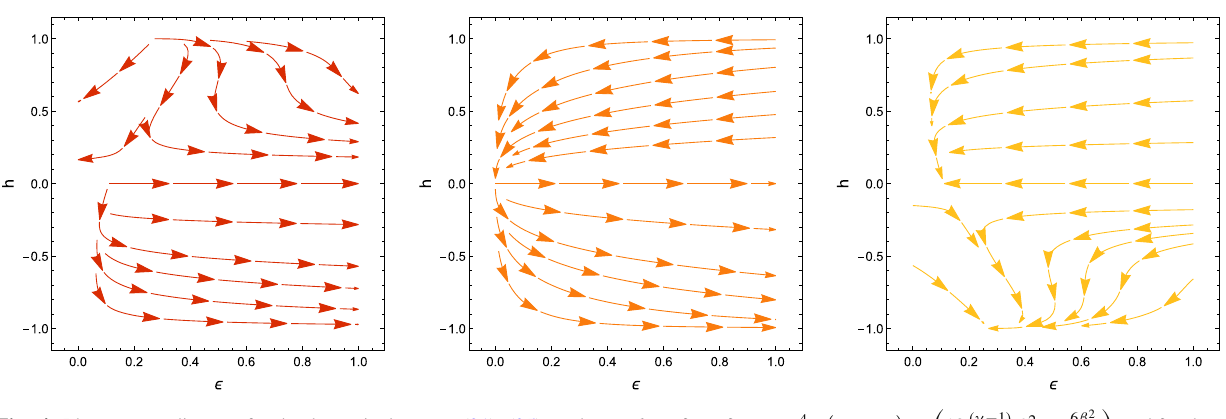
Fig. 4 Phase-space diagram for the dynamical system (31)–(35) on the ε − h surface, for γ = 4 different values of β . The middle figure is for β = 0, the left figure for β < 0 and the right figure for β > 0 .